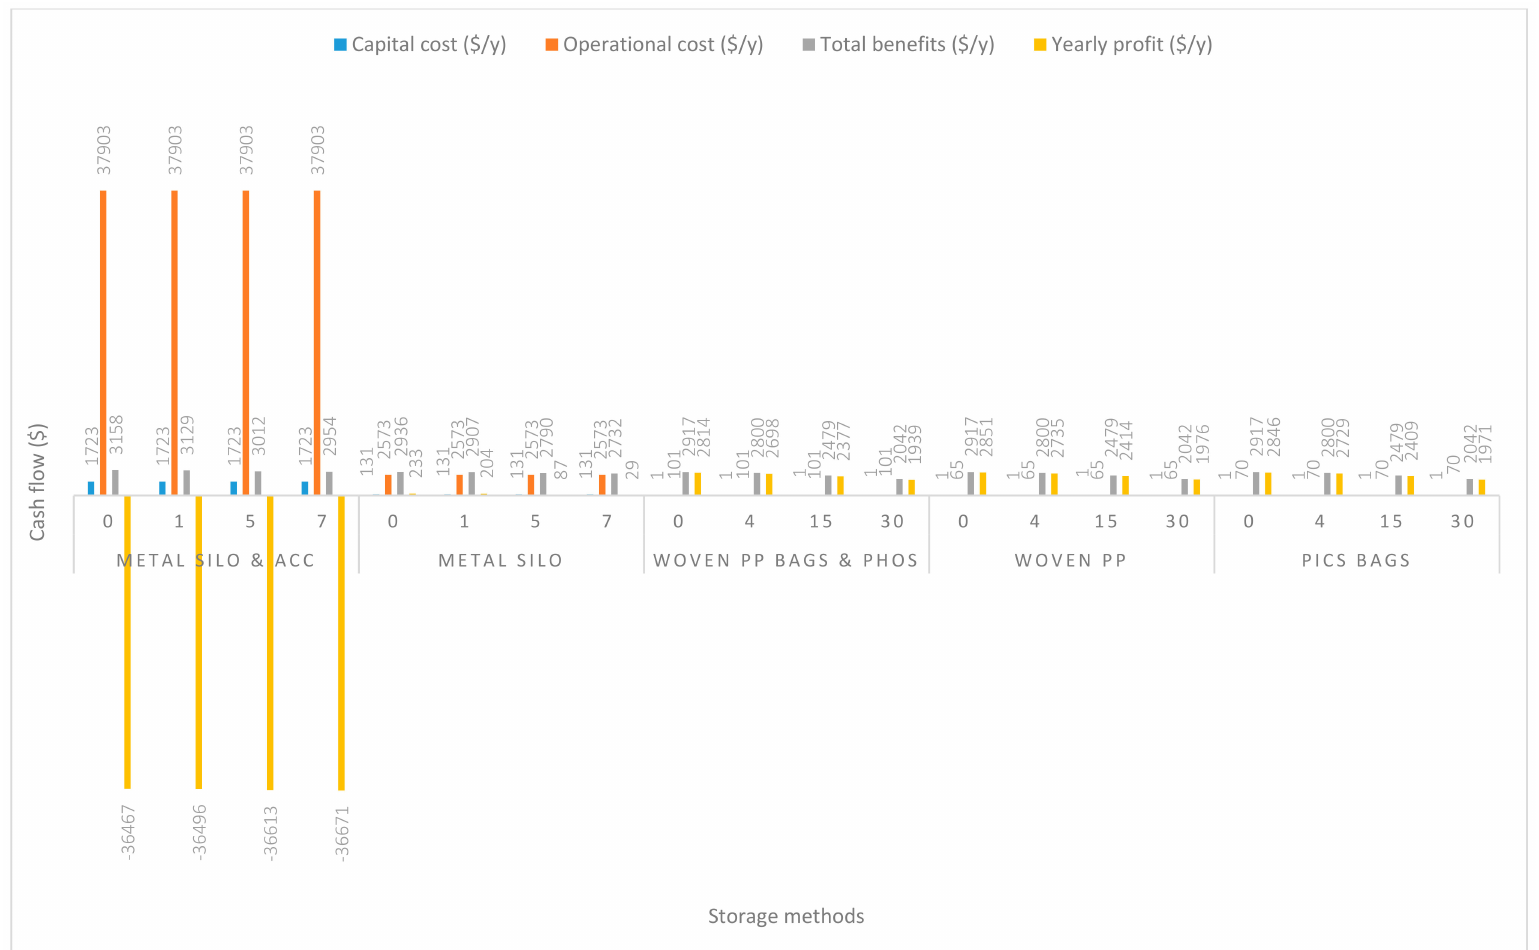
Figure 6. Annual capital and operational costs (US dollars), total annual benefits and profits (US dollars) for each handling / storage method at 14 Mg / y handling capacity for 0% to 7%, and 0% to 30% grain quantity